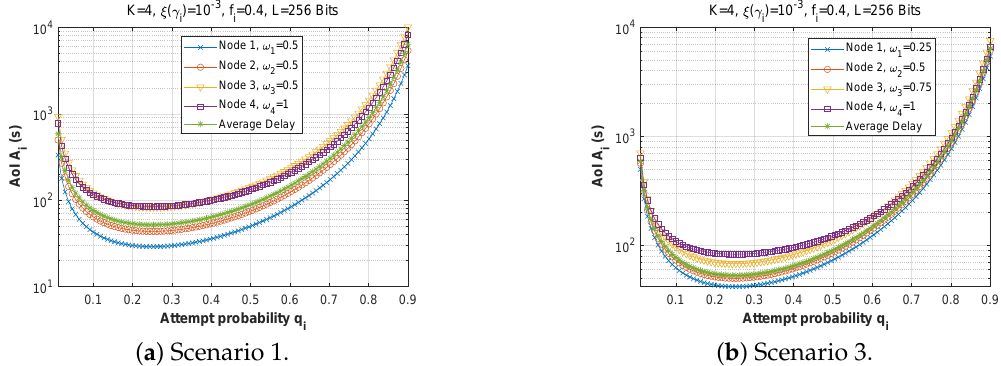
Figure 28. The AoI experienced at each mobile device as a function of attempt probability q i for various arrival rates λ Q i